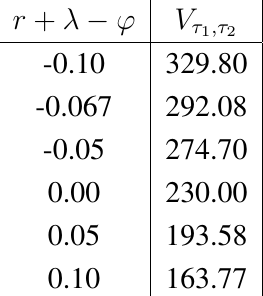
Table 5. Sensitivity of V